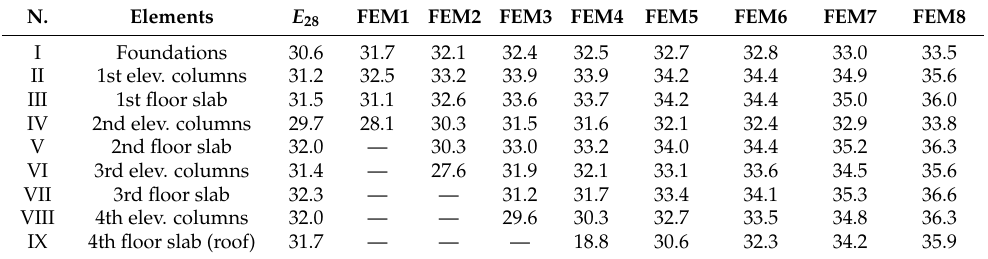
Table 5. Dynamic elastic moduli of the concrete ( E d ) in [GPa] assumed for each of the eight FEMs. N.